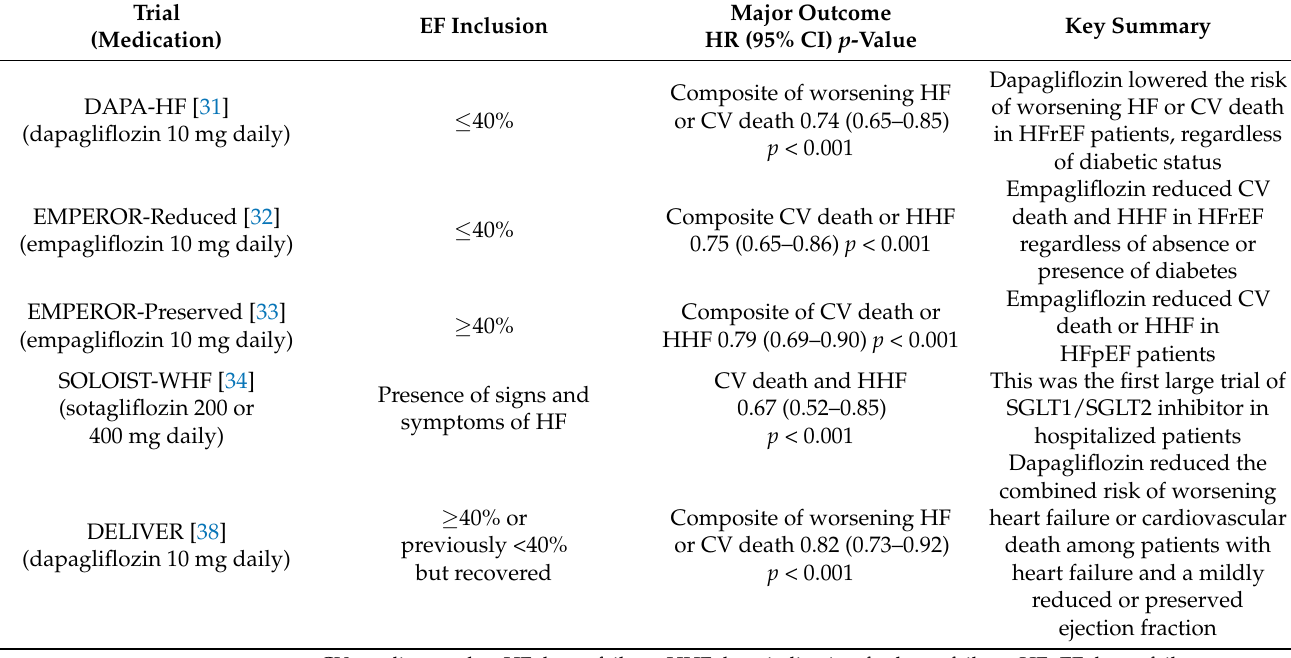
Table 7. Sodium Glucose Cotransporter 2 Inhibitor heart failure